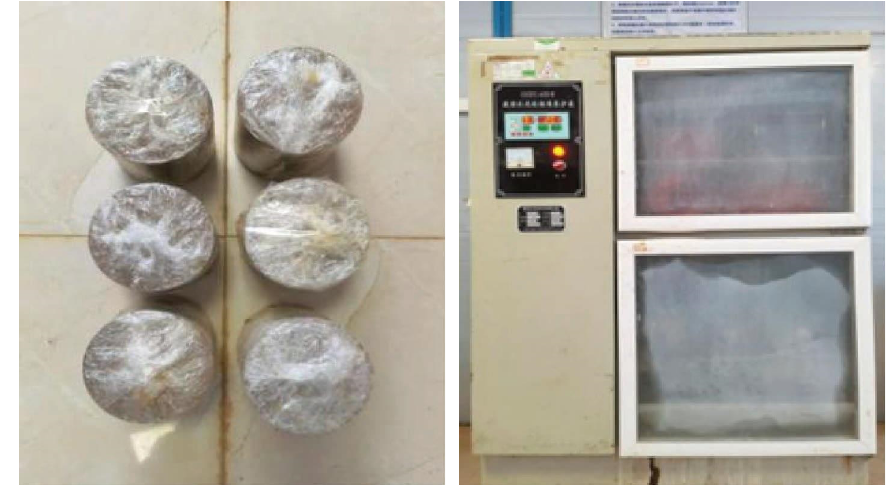
Figure 3: Samples and standard curing boxes.